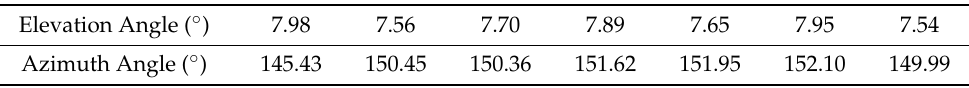
Table 4. DOA estimation by CPCMA-ESPRIT for outer race fault signal at 290 rpm. Elevation Angle (°)